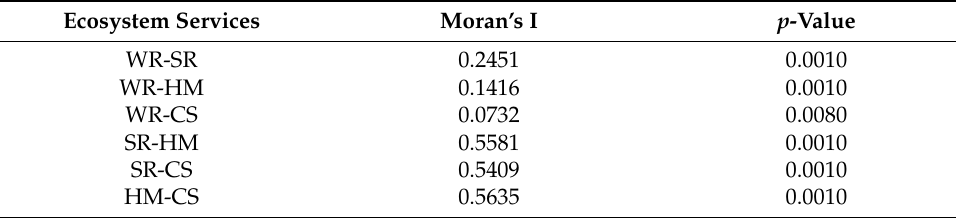
Table 3. Moran’s I index of ecosystem services in the BTH